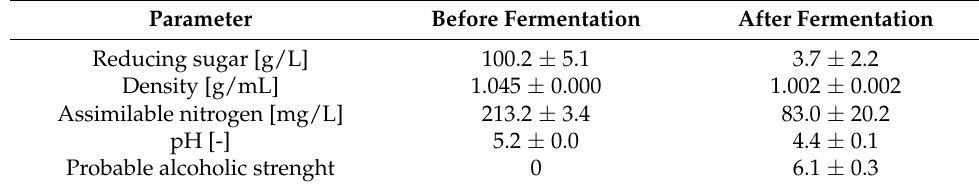
Table 4. Average results (with standard deviation) of different parameters before and after fermen- tation.